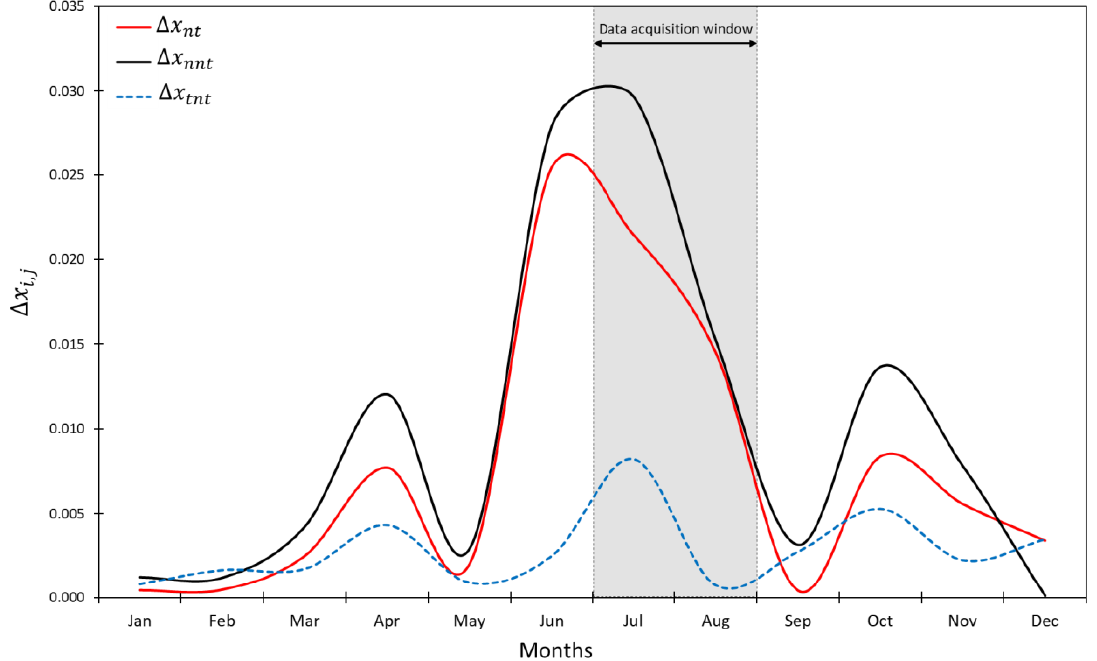
Figure 4. The monthly averages of 17 years NDVI of differences between native and tame grasslands ∆ x nt , differences between native and mixed grasslands ∆ x nnt and differences between tame and mixed grasslands ∆ x tnt .